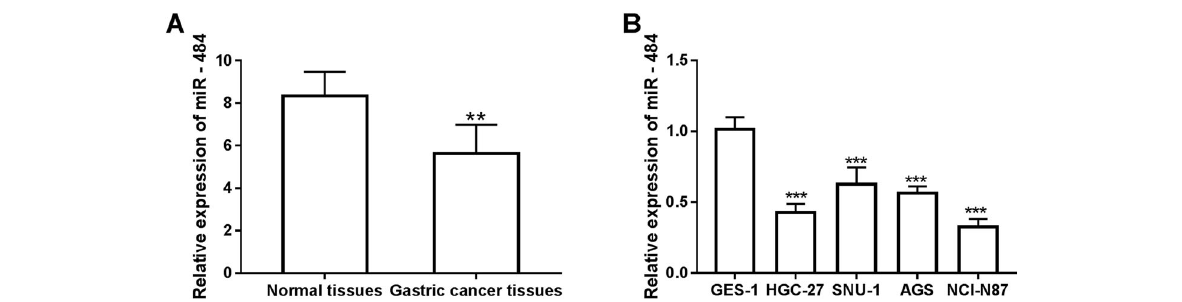
Fig. 1 Expression of miR-484 in gastric cancer tissues and cell lines. a . Expression of miR-484 was downregulated in gastric cancer tissues compared with adjacent normal tissues. (** P < 0.01, *** P < 0.001). b . Expression of miR-484 was decreased in gastric cancer cell lines (HGC-27,